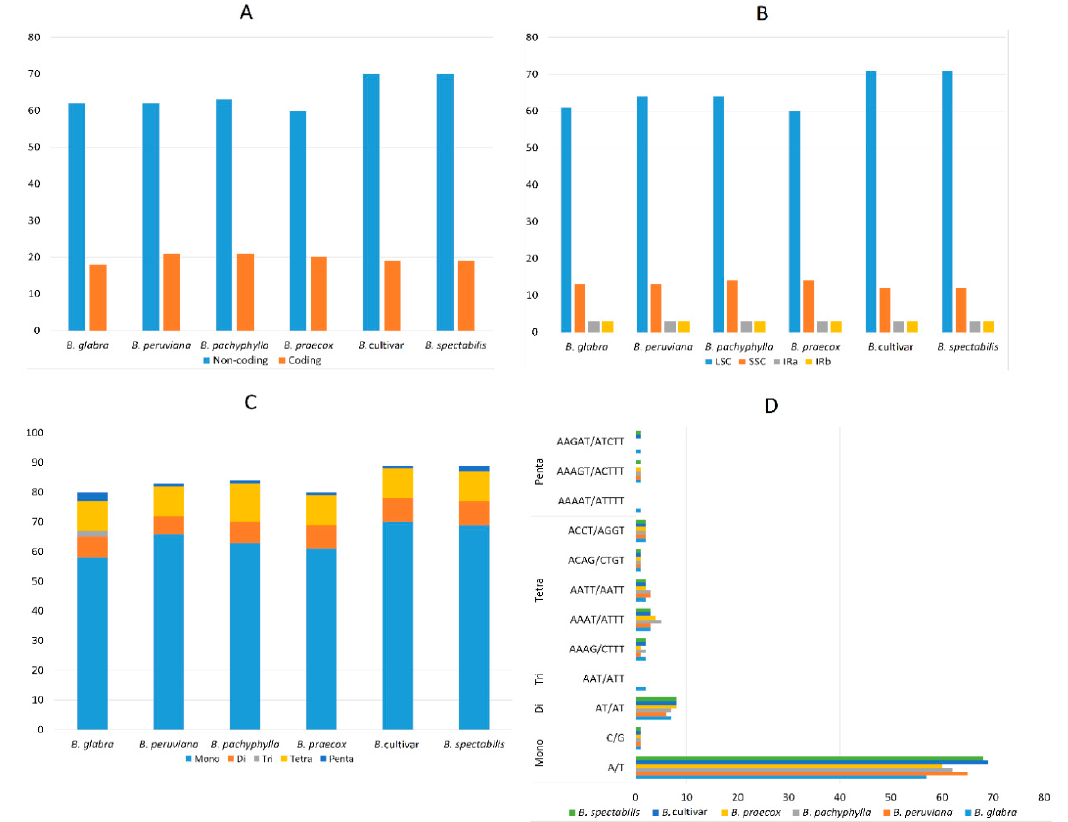
Figure3. Analysisofsimplesequencerepeats(SSRs)insix Bougainvillea chloroplastgenomes. ( A )Simple sequence repeats detected in coding and non-coding regions of six Bougainvillea cp genomes. ( B ) Simple sequence repeats distributions in the LSC, SSC, and IR regions of Bougainvillea cp genomes. ( C ) Numbers of di ff erent types of SSRs identified in the Bougainvillea cp genomes. ( D ) Frequency of various SSR types identified in six Bougainvillea cp